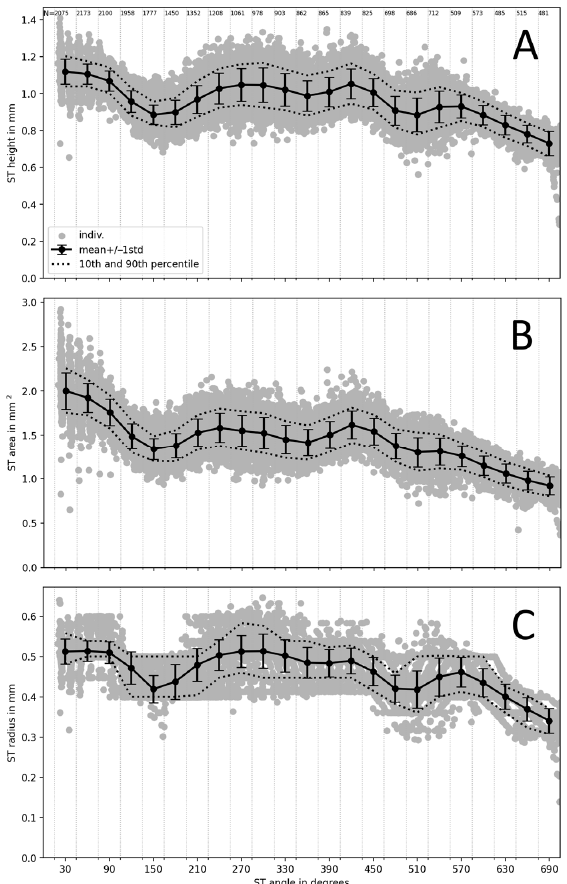
Figure 4. Scala tympani maximum vertical height ( A ), area ( B ) and radius of largest fitted circle ( C ) as a function of the angular distance. Dots represent individual measurement points. Error bars rep- resent the mean and ± 1 standard deviation; dotted lines show the 10th and 90th percentiles. Vertical dotted grid lines indicate the angular distance bands that were used to select the N measurement points indicated at the top of panel A to calculate the